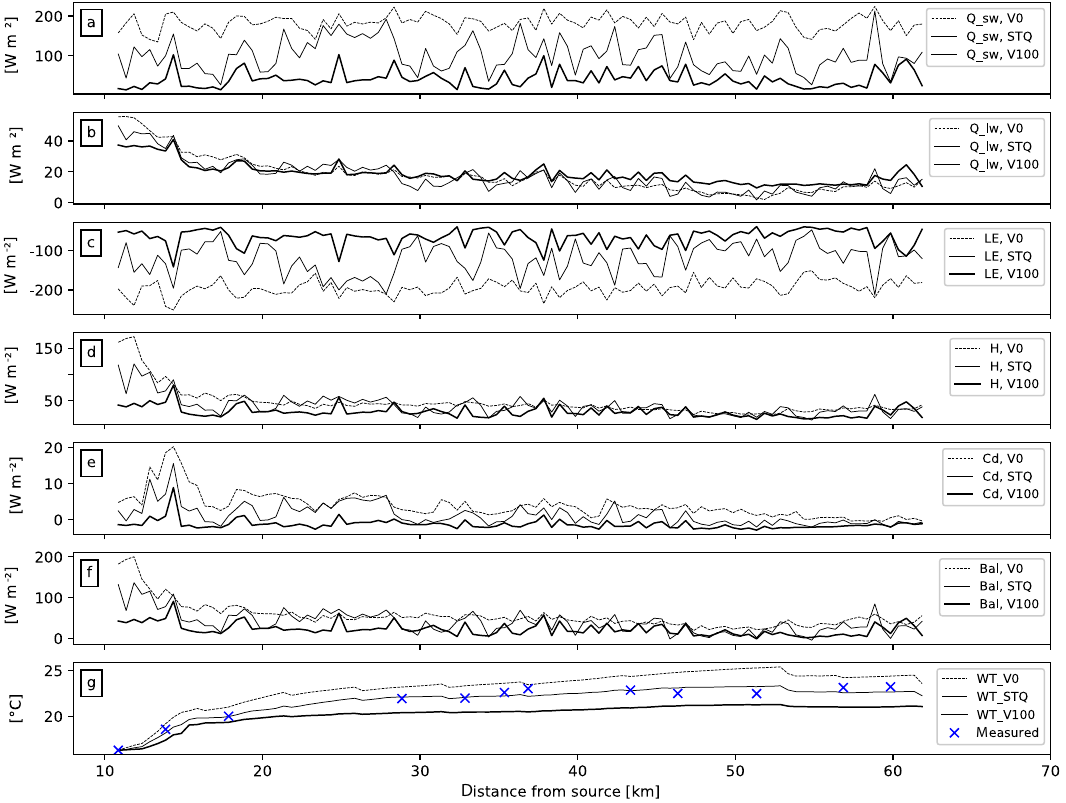
Figure 3. Comparison of (a) the calculated shortwave, (b) longwave radiation balance, (c) latent and (d) sensible heat fluxes, (e) conduc- tion heat flux, (f) total energy balance, and (g) measured (measured) and simulated (WT) water temperature for the heat wave episode 4–8 August 2013 along the Pinka for three vegetation scenarios: no vegetation (V0), existing vegetation (STQ) and maximum vegetation (V100).